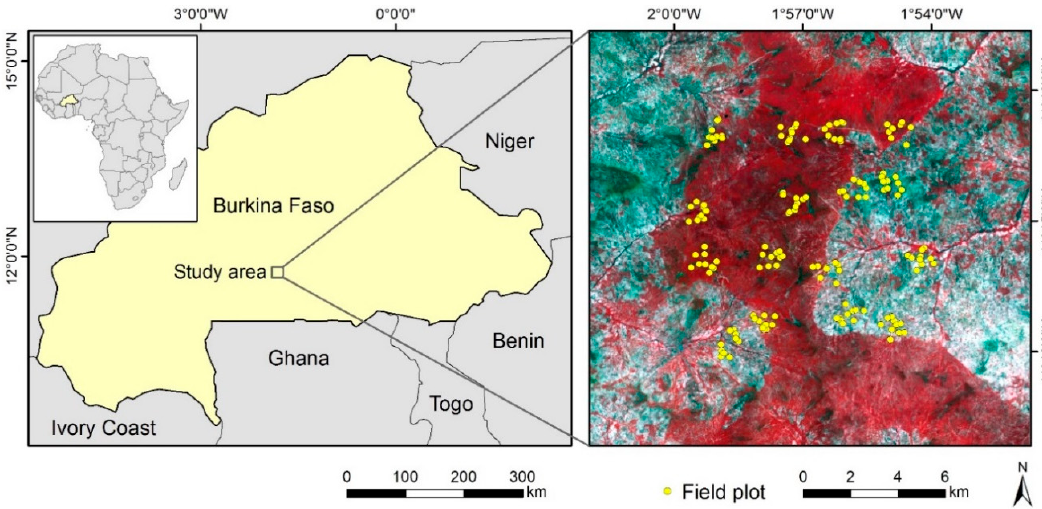
Figure 1. The location of the study area and field plots on top of a false color composite of a Landsat 8 image acquired on 8 June 2014 (RGB: near-infrared, red, green).